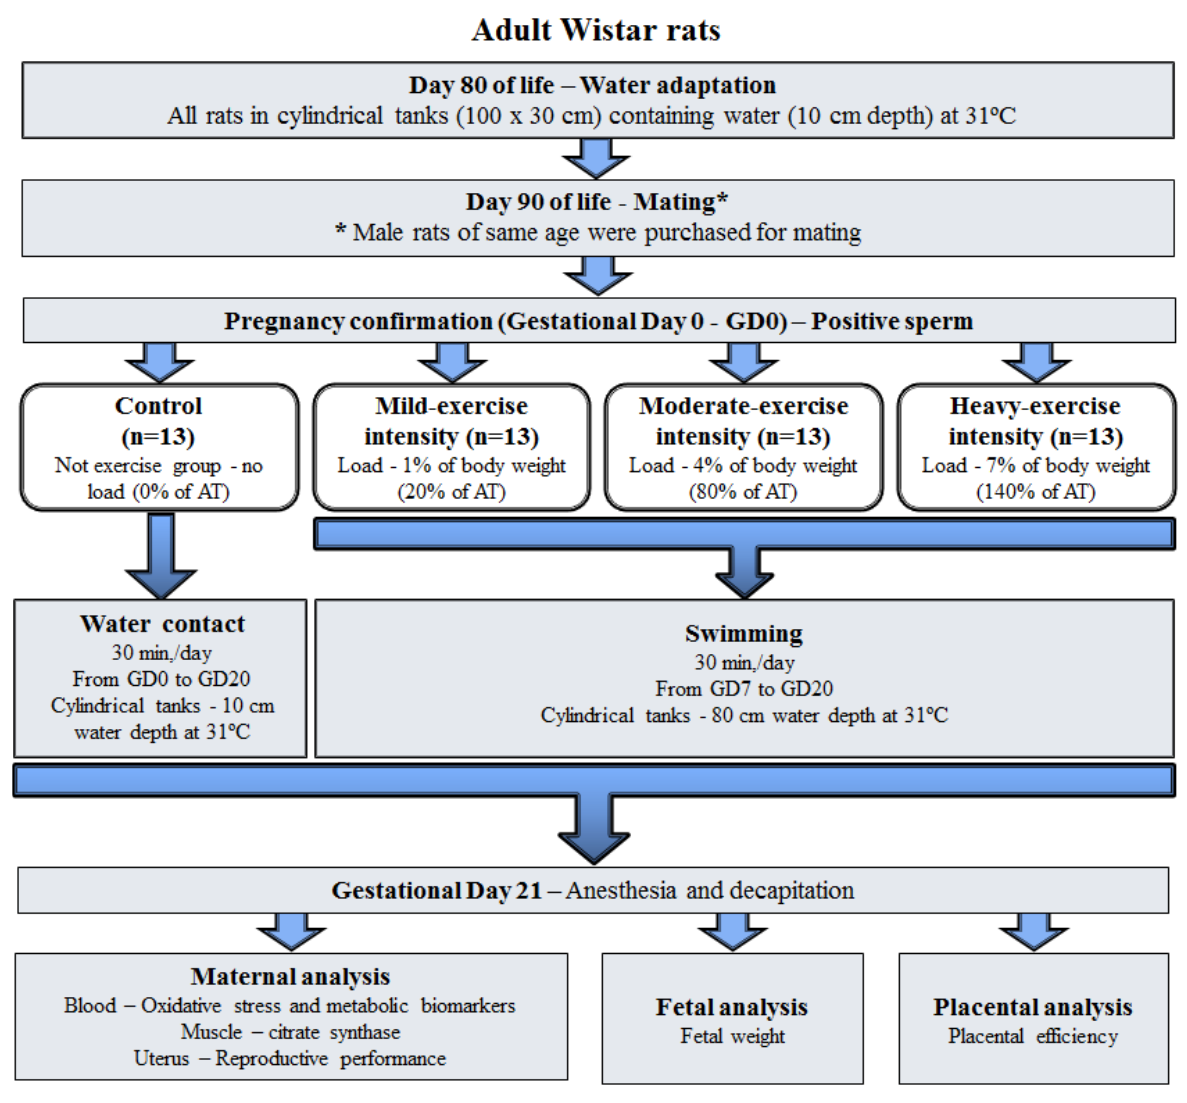
Figure 1. Experimental